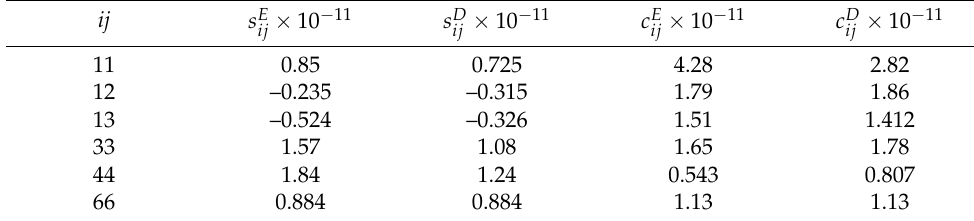
Table 1. The full set of BaTiO 3 single crystal-flexibility